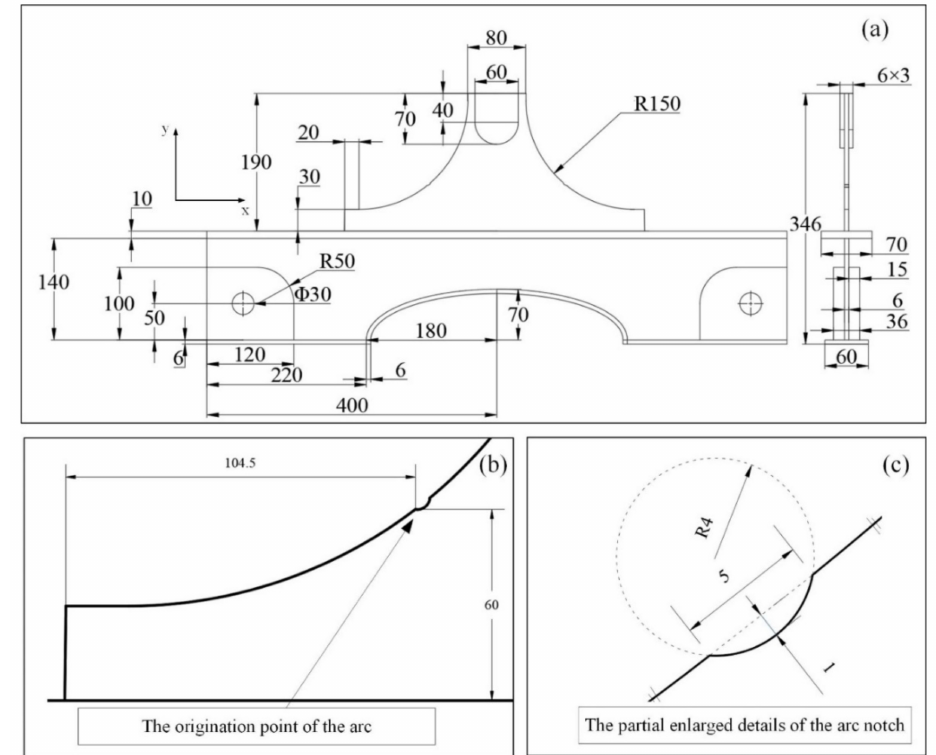
Figure 3. The geometry of the hatch corner specimen ( a ) and the arc notch ( c ) with the location of its origination point ( b ).